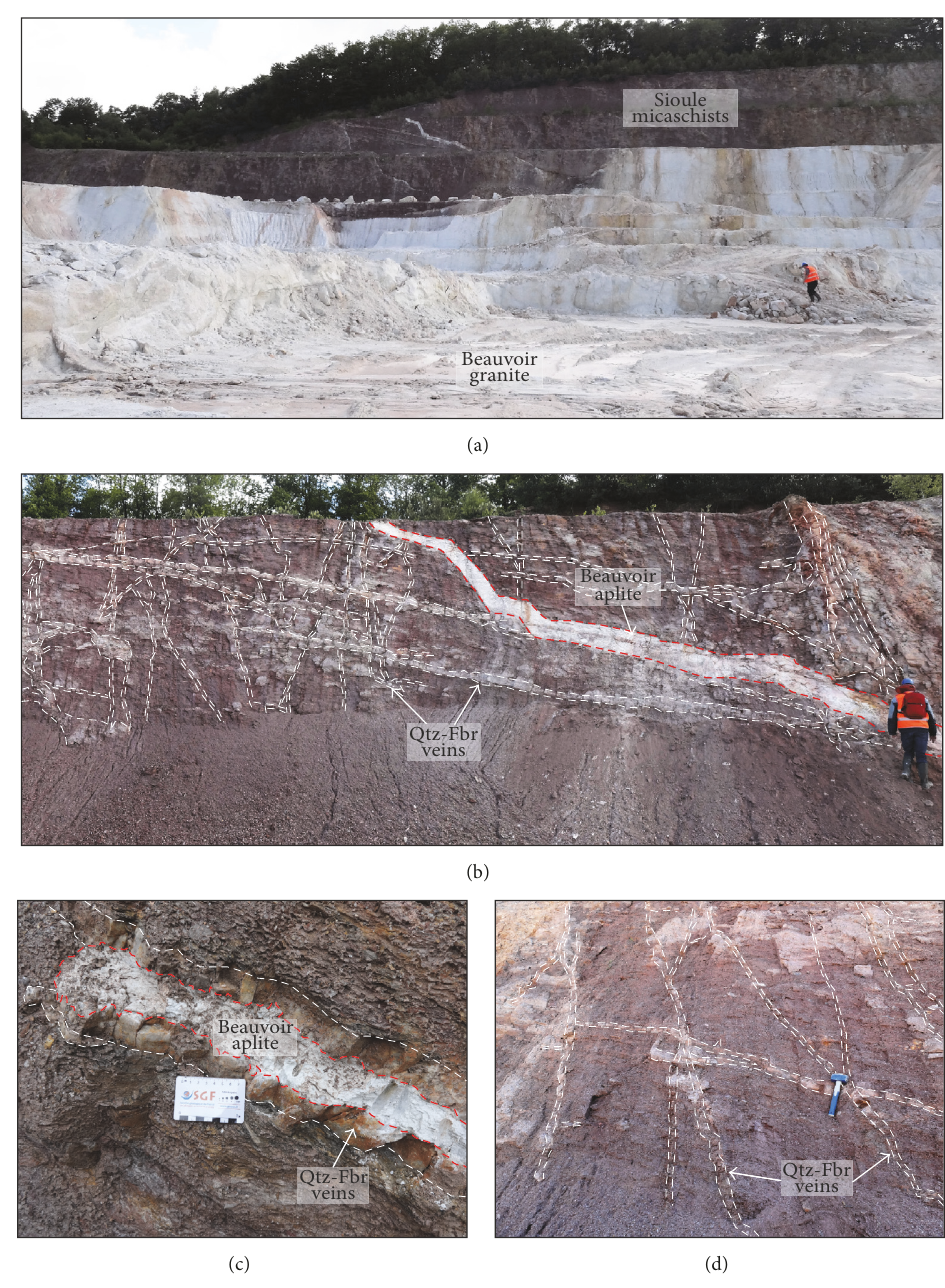
Figure 3: Field photographs of the Beauvoir granite and relationships with the enclosing micaschists. (a) General overview of the upper part of the kaolinized Beauvoir granite intrusive into the Sioule micaschists. (b) Aplite dyke derived from the roof of the Beauvoir granite that crosscut the preexisting quartz- (Qtz-) ferberite (Fbr) veins in the enclosing micaschists. (c) Detailed view of a Beauvoir aplitic dyke reopening an older quartz-ferberite vein. (d) Detailed view of the W stockwork showing the two sets of subparallel and oblique veins that crosscut the